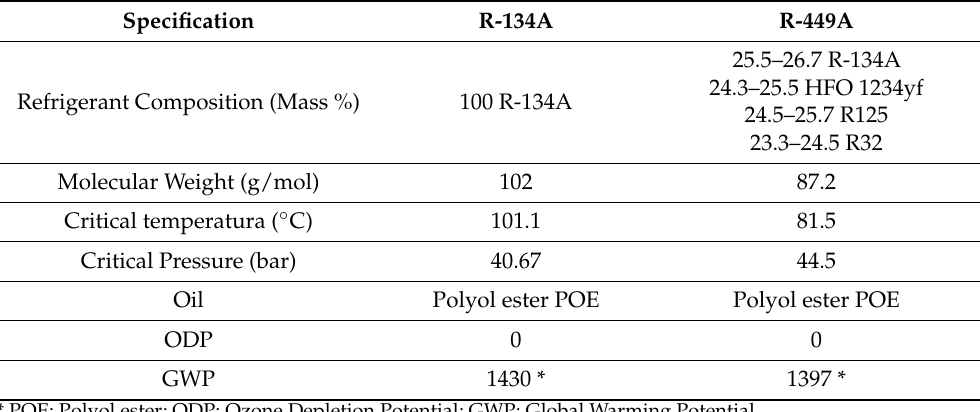
Table 2. The environmental and physical properties of tested